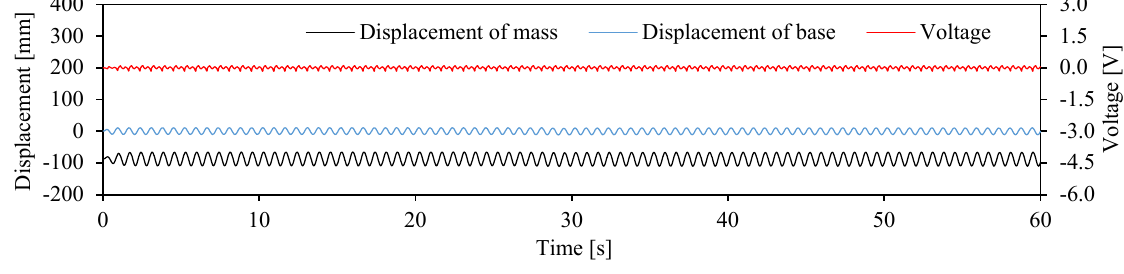
generated. Figure 12. Measurement results for 1.3 Hz periodic signal excitation. Figure 12. Measurement results for 1.3 Hz periodic signal excitation.